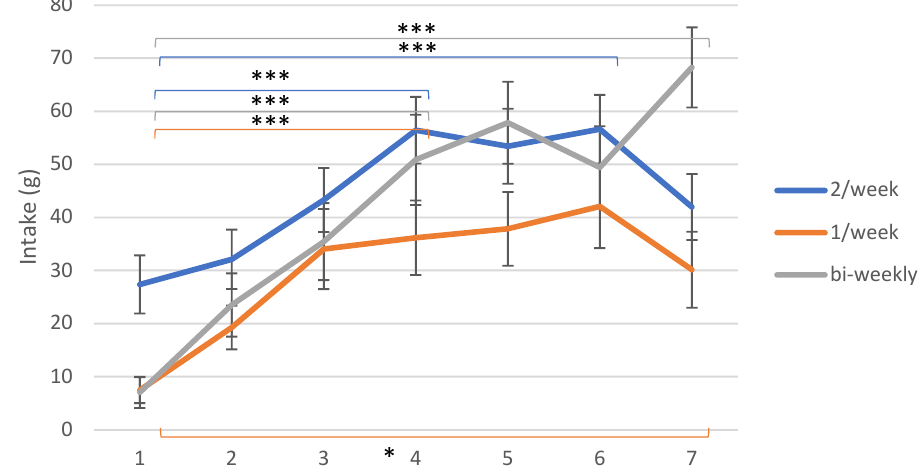
Figure 3. Mean intake scores ± SEM in g of daikon of the different intervention groups for each exposure session (1–7). The significance of the differences between selected sessions is depicted for all exposure groups. All groups showed a significantly higher intake at the 4th and the 7th exposure compared to the 1st one. The detailed differences and their statistical significance are given in the text. Significance levels: ‘***’: ≤ 0.001, ‘*’: ≤